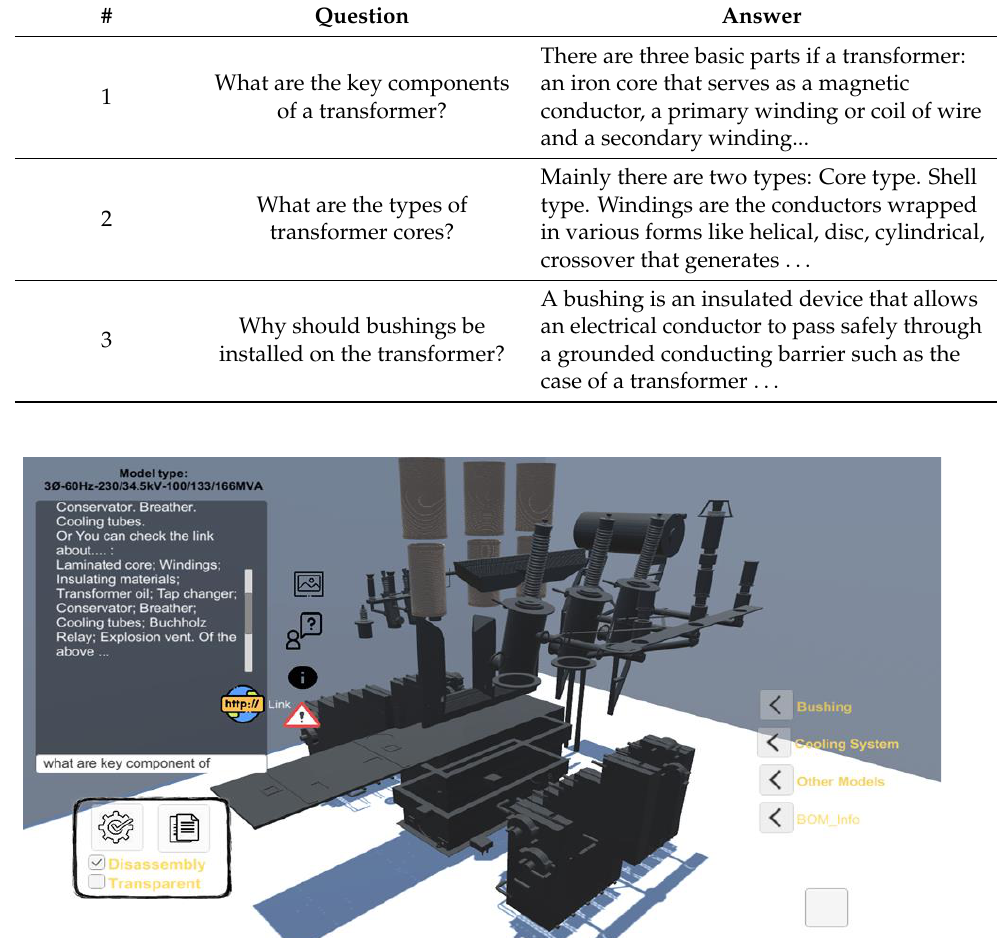
Table 8. Demonstrations of Q&As and VR interactions in VR Chatbot.